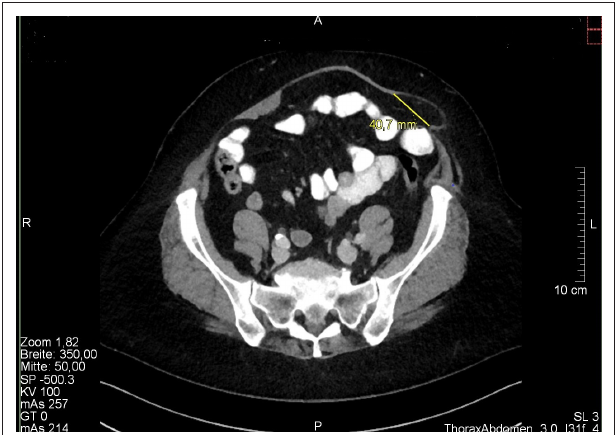
FIgure 6 | Off-midline hernia with a hernia diameter of 4